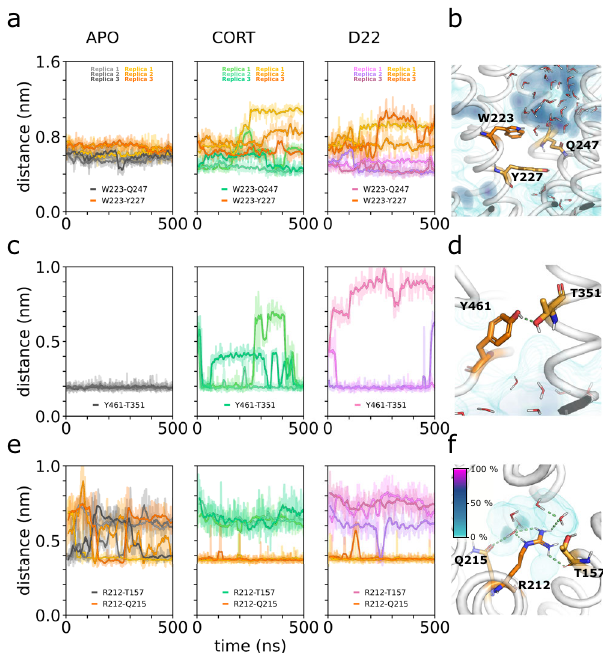
Fig. 5 | The possible underlying causes of function disruption in genetic var- iants of OCT3. a Distance between the side chains of W223 and Y227 or Q247, indicating the orientational dynamics of the sidechain of W223. b Local environ- ment of W223, showing average water molecules occupancy in its proximity. c Donor-acceptor hydrogenbond distancebetween Y461 and T351, con fi rming the long-range effect of the bound inhibitor on the local structural stability of the Y461 site. d Zoom onto Y461, showing the hydrogen bond to T351 and averaged water occupancy in its proximity. e Distance of the side chain of R212 to residue T157 and Q215, highlighting the oscillation of the interaction pattern in the apo statecomparedtothestableconformationintheinhibitorboundstates. f Close-up of R212, emphasizing on the hydrogen bond network formed with residues Q215, T157and watermolecules.Averaged spatialoccupancyofwaterisrepresentedasa density colored according to the